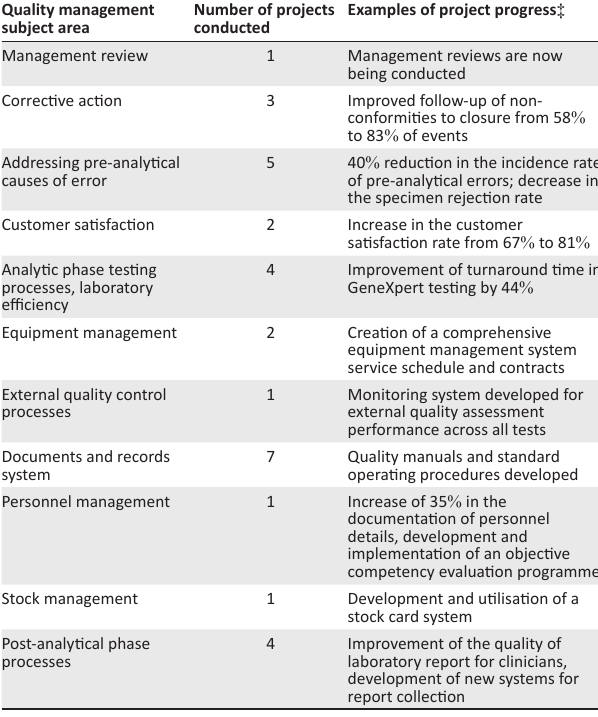
TABLE 3: Capstone project topic areas, Zambia, 2016–2018.